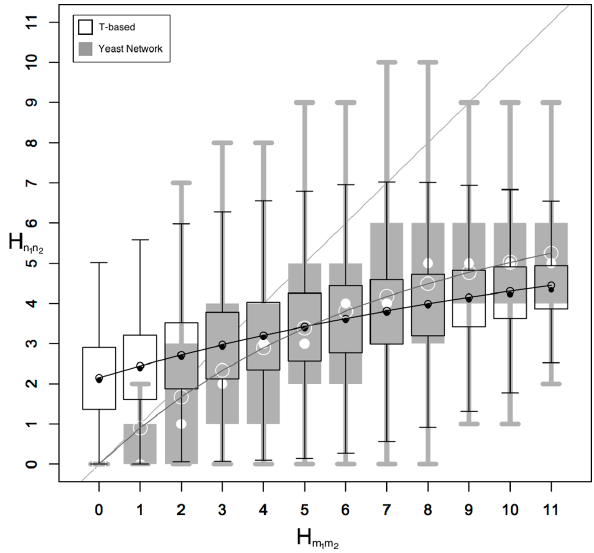
Figure 2. Derrida Plot Comparing Yeast Cell Network and Cell Cycle Process T. This plot compares the putative yeast cell cycle network (grey) and T supporting the yeast cell cycle process (black). We have extended the plot to show median (solid points) plus box-and- whiskers in addition to means (open points). For this size system, we were able to evaluate a complete population instead of sampling. The putative cell cycle network is stable according to the Derrida coefficient: i.e. , the mean values form a trajectory below the 45 0 line. The T -based results require more interpretation and context. Notably, states with H